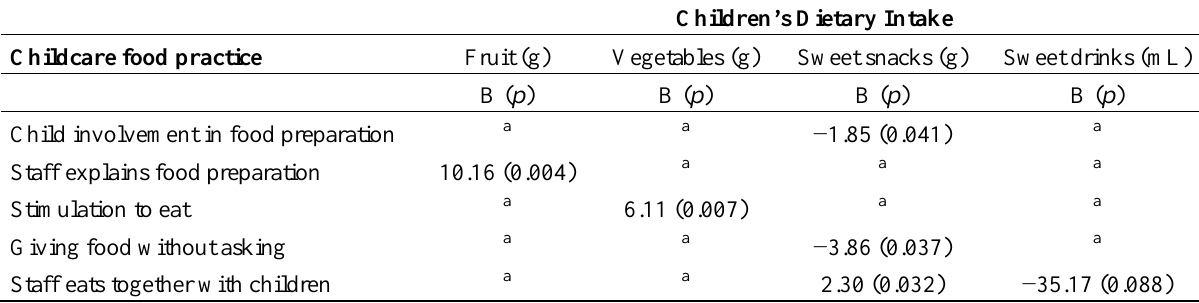
Children’s Dietary Intake